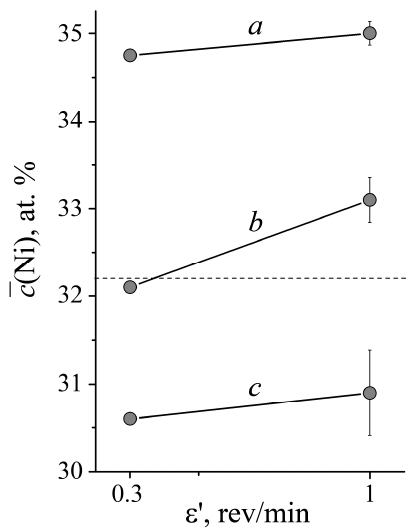
Figure 17. The dependence of the nickel content c ( Ni ) in the matrix of the alloy Fe 55 Ni 36 Al 9 on the rate ε of its deformation at temperatures ( a ) 293 K, ( b ) 473 K, and ( c ) 573 K on the degree of deformation equal to ε = 4.8 (1 rev.).